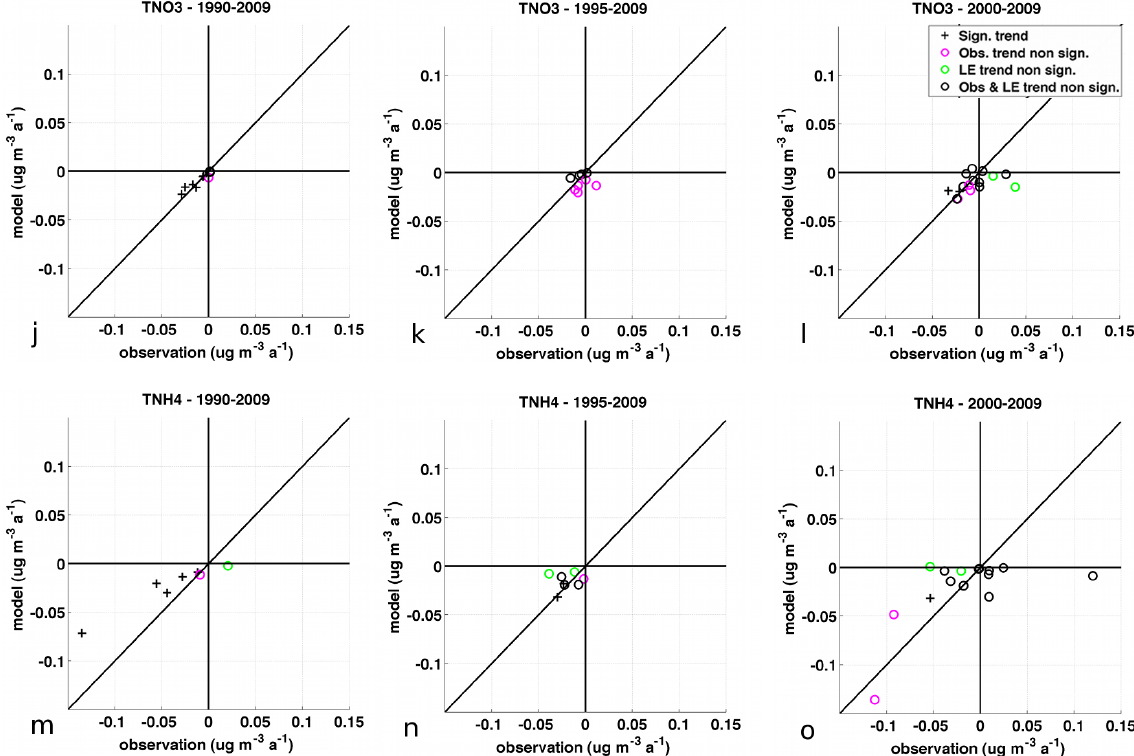
Figure 4. Scatter plots of the observed versus modelled trends for the studied components at the considered stations for the three different time periods. At each individual station, the marker (described in the legend on the top right of the plot) indicates whether the observed and/or modelled trend is significant following the Mann–Kendall test at a 95% confidence